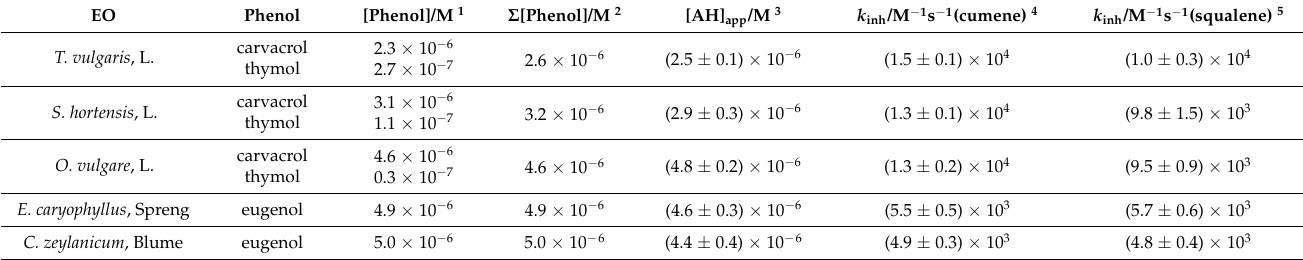
Table 2. Inhibition rate constants at 30 ◦ C (PhCl) measured for the EOs in the autoxidation of cumene and squalene and apparent concentration of the antioxidant (mean ± SD), matched to the concentration of phenolics estimated from analysis of the EO (1